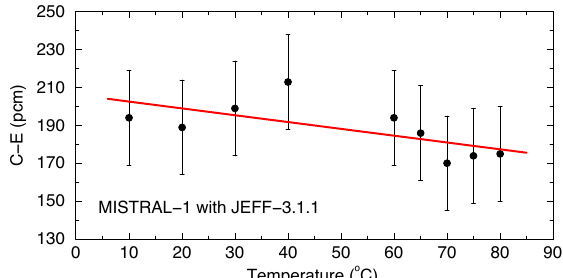
Fig. 5. Differences in reactivity for the MISTRAL-1 core expressed in terms of C-E obtained with the Monte-Carlo code T ripoli -4 (cid:114) and the JEFF-3.1.1 library up to 354 K (80 ◦ C). The solid line represents the best-fit curve reported in reference [25]. The present calculations account for the thermal expan- sion of the materials, while in the past study [25], the thermal expansion was taken into account as a correction factor of the Monte-Carlo results. The reported uncertainties only take into account the uncertainties of the kinetic parameters, measure- ments of the doubling time and boron